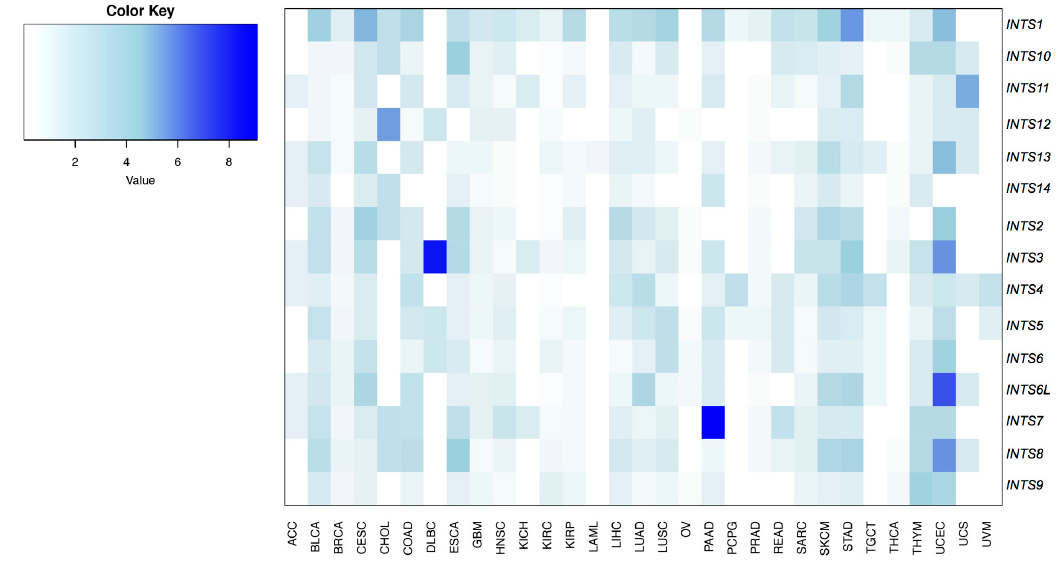
Figure 2. Frequency of patients carrying mutations in the INT subunits across the 31 analyzed tumors.